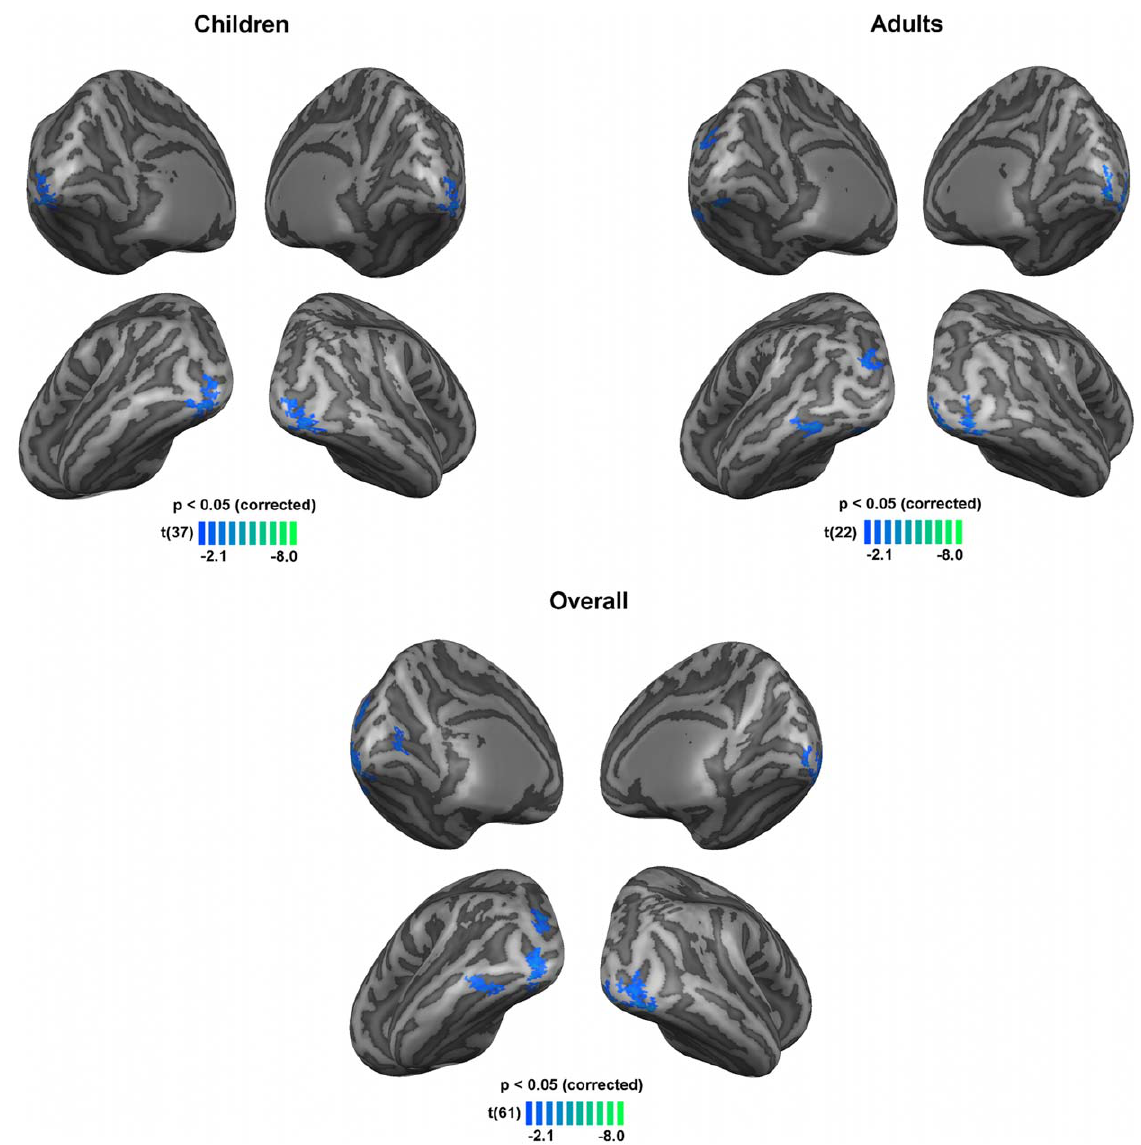
Figure 3. Significant differences in brain activations between patients with NF1 and controls, regarding the P-biased stimulus for children, adults and overall (children and adults) groups. Blue colours depict regions where activation was lower for individuals with NF1 than controls. Results are shown on views of the left and right hemispheres of cortex-based aligned three-dimensional reconstructions generated from the average anatomical data sets of the subjects in each group (children, adults, overall). Light grey represents gyri, dark grey represents sulci. T- maps thresholded at p , 0.05 corrected using cortex-based cluster threshold estimation (cluster size 41 mm 2 ). N=15 children with NF1, 24 control children, 13 adults with NF1 and 11 control